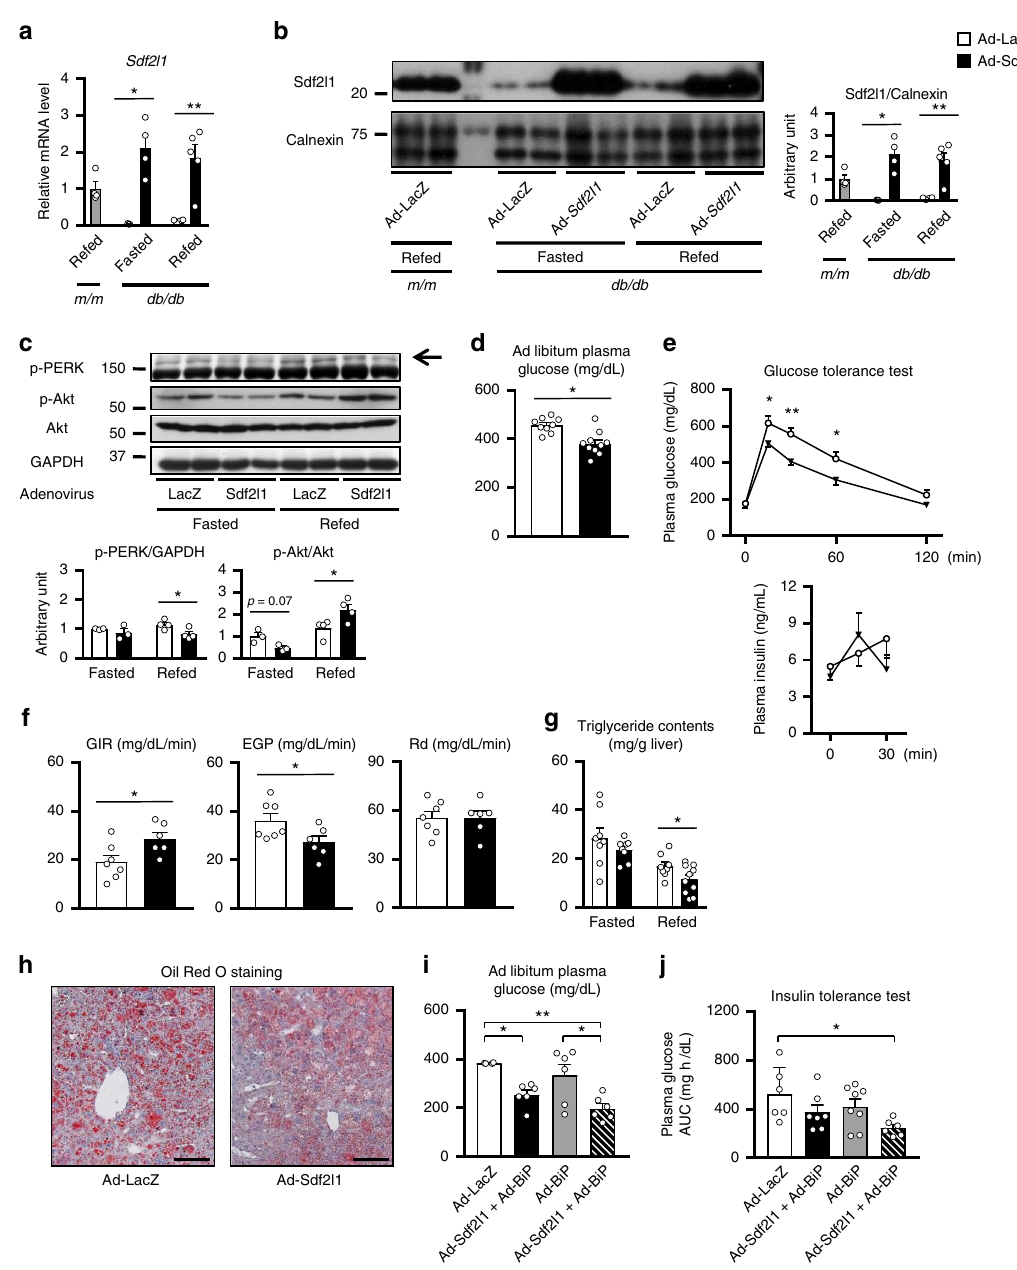
Fig. 6 Restoration of Sdf2l1 expression in an obesity and diabetes model. a – h db/db mice were administered with Ad-Sdf2l1 intravenously (2.5 × 10 7 PFU/g BW), for restoration of the gene expression in the liver. a – c ER stress and insulin signaling in the liver, analyzed by a RT-PCR ( n = 3 – 5), b Western blotting of microsomal fractions ( n = 3 – 5), and c Western blotting of total lysates ( n = 3 – 4). d – f Effects of the restoration on glucose metabolism ( n = 9 – 10), including d plasma glucose levels in an ad libitum-fed state, e plasma glucose levels in OGTT, as well as insulin levels, after oral administration of glucose (0.75 g/kg BW), following 24 h of fasting. f Results of hyperinsulinemic-euglycemic clamp studies (12.5 mU/min/kg, n = 6 – 7), after 3 h of fasting. g , h Effect of the restoration on lipid metabolism, analyzed with g triglyceride contents quanti fi cation ( n = 8 – 10), and h Oil Red O staining. i , j Phenotypes of db/db mice co-administered with Ad-Sdf2l1 and Ad-BiP-HA, assessed with one-way ANOVA: i plasma glucose in an ad libitum-fed state ( n = 4 – 6), and j the area under the curve (AUC) of plasma glucose in ITT, after intraperitoneal injection of human regular insulin (1.5 U/kg BW) ( n = 6 – 8). Values of the data are expressed as mean ± SEM. * P < 0.05, ** P < 0.01. a – g Unpaired 2-tailed t -test was used, and i , j one-way ANOVA was used for assessment. Scale bars: 100 μ